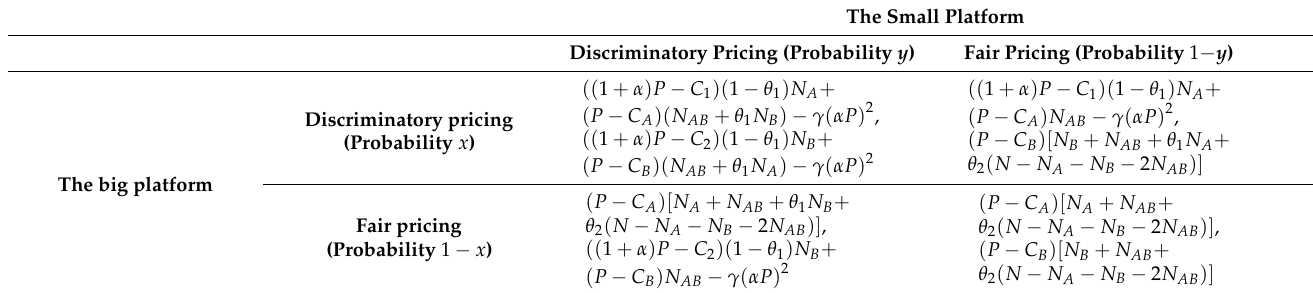
Table 1. Payment matrix of the big platform and the small